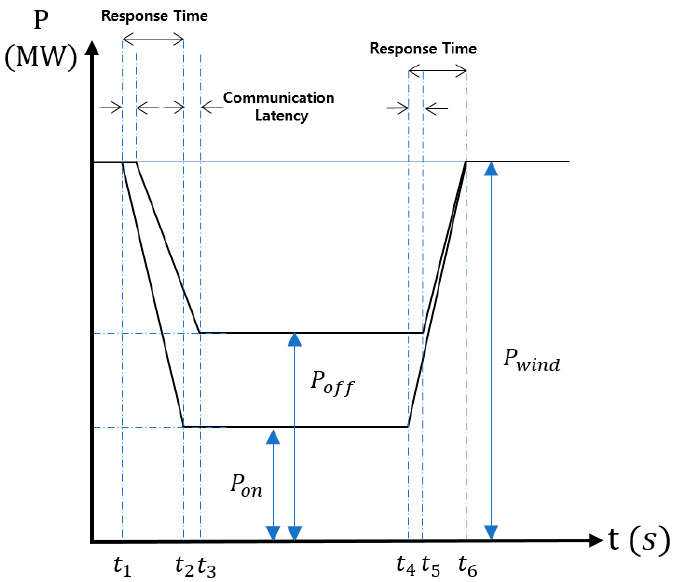
Figure 4. Studied system model of the off-shore wind farm.